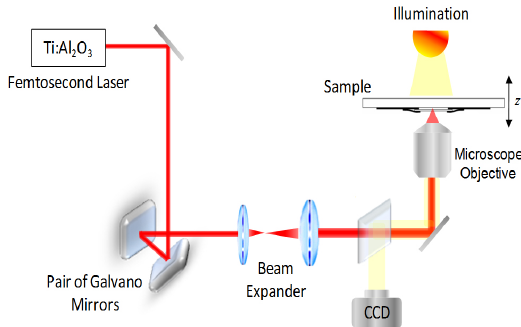
Figure 2. Experimental setup employed for microfabrication using two-photon absorption polymerization.